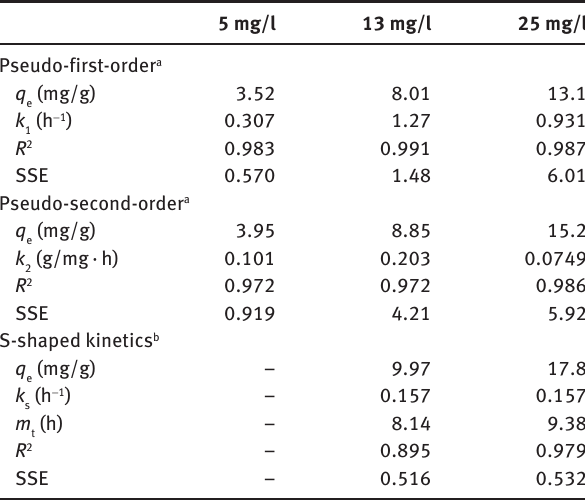
Figure 6: Intraparticle diffusion